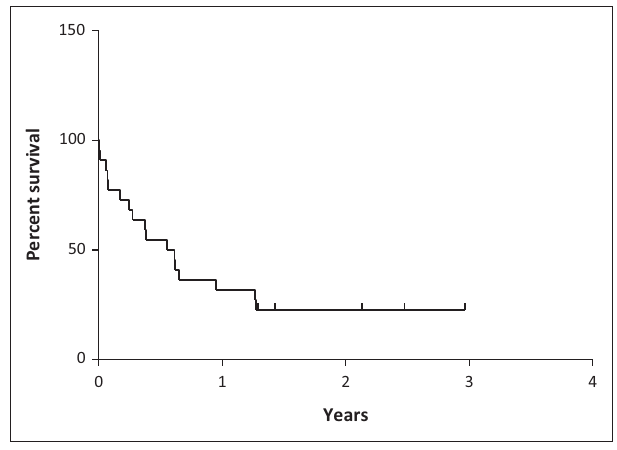
FIGURE 2: Overall survival of patients with CML in blast phase Johannesburg, South Africa, 08 April 2016 to 16 October 2019, excluding one patient, who was lost to follow-up.